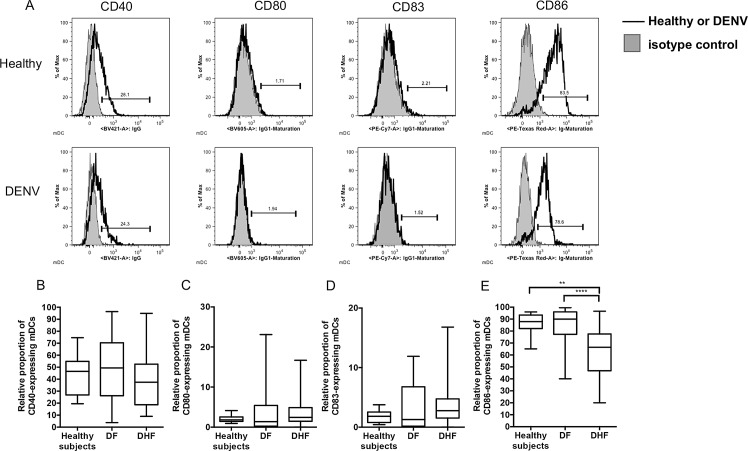
Comparison of the expression of potential markers of relative mDCs maturation during acute DENV infection.(A) Representative histogram plots showing maturation markers on mDCs on blood samples from healthy subjects (solid black line, upper panel) and DENV-infected patients (solid black line, lower panel). The shaded grey histograms represent profiles obtained using isotype controls. The relative proportion of CD40 (B), CD80 (C), CD83 (D), and CD86 (E) -expressing mDCs were compared on samples from healthy subjects and DENV-infected patients, DF and DHF patients. The box plot shows the median value (horizontal line in the box). The box and whisker represent 25th to 75th, and 10th to 90th interquartile range, respectively. P values were determined by the Dunn’s post-test after Kruskal-Wallis test for comparison of three groups. (** p < 0.01 and **** p < 0.0001).